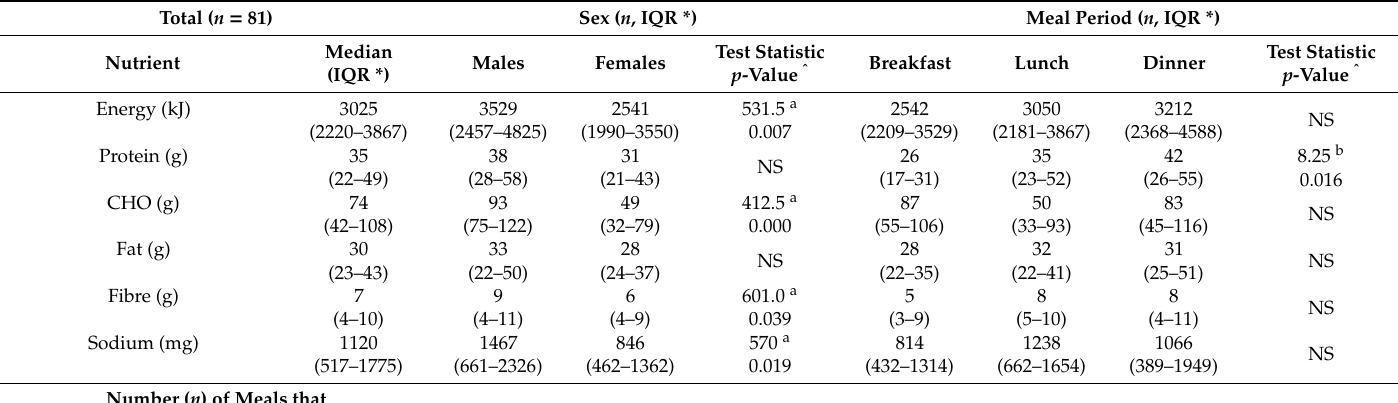
Table 3. Nutrients, food groups, variety and volume of athletes’ meal